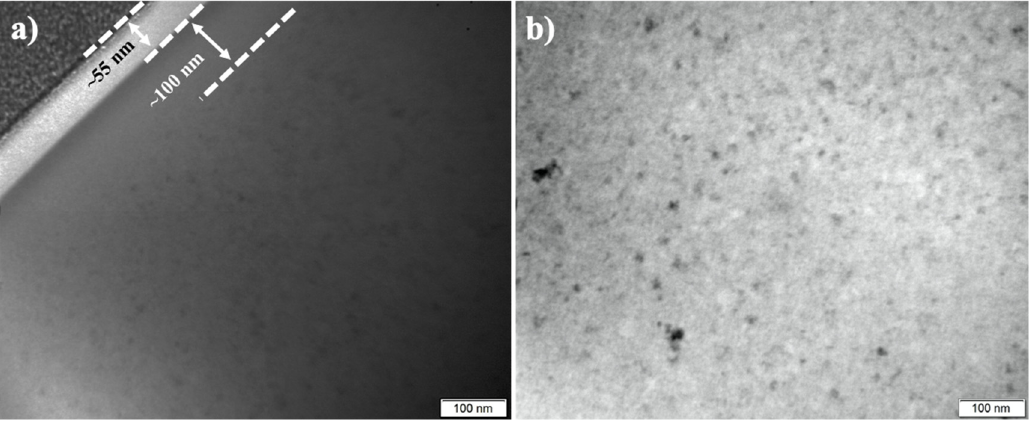
Figure 3. BF ‐ TEM image of 380 ‐ 4.5, showing a ) surface and b ) core ( ≥ 3 μ m deep).